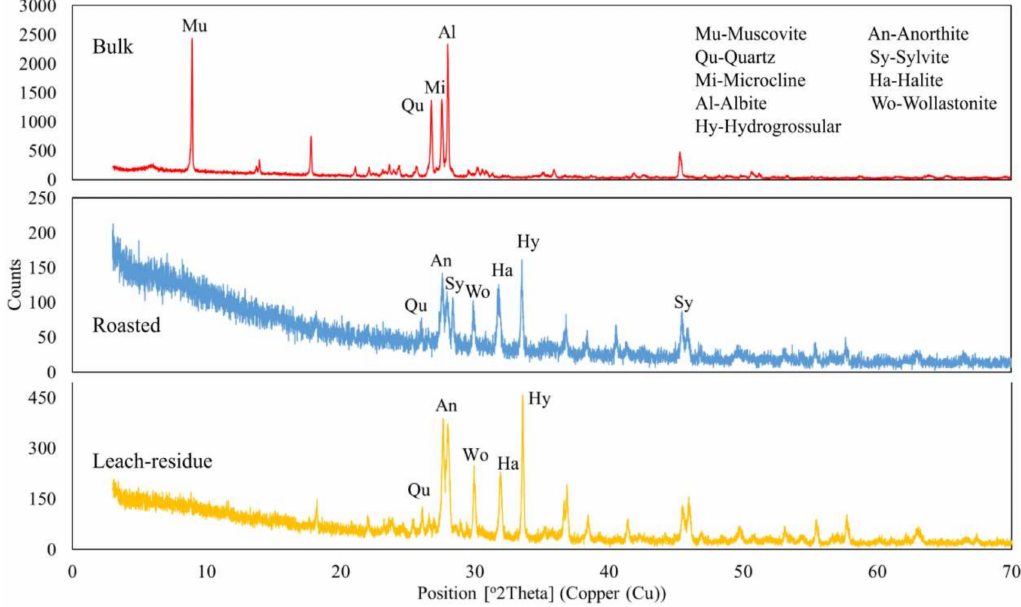
Figure 9. XRD patterns of bulk, roasted and leach